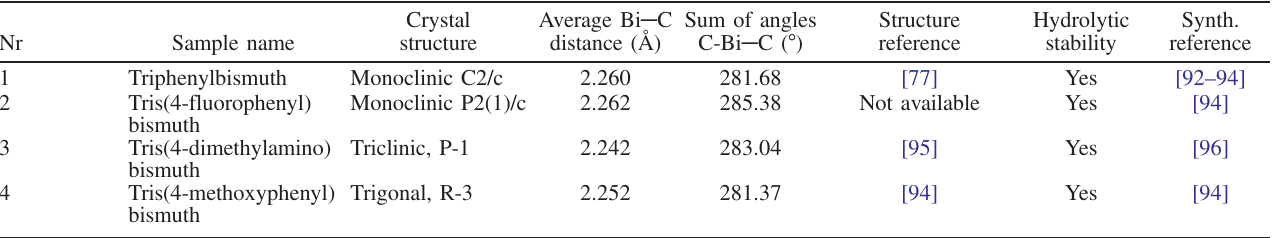
TABLE V. Sample overview; crystal structures, structure info, references and